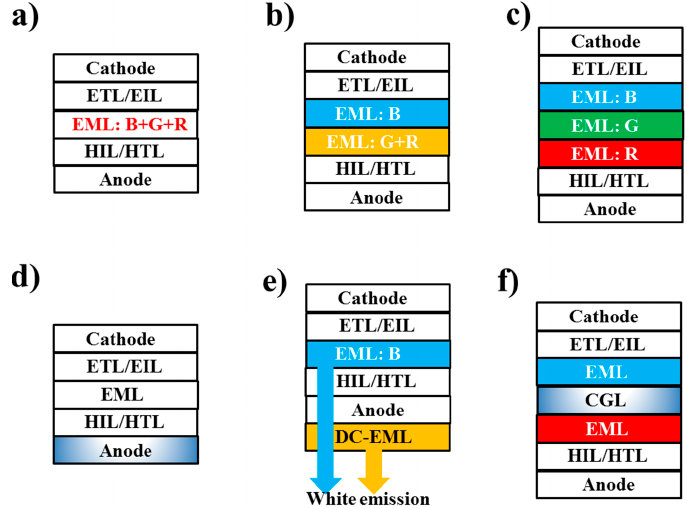
Figure 3. Schematic diagram of device architectures of WOLEDs. HIL is the hole injection layer, HTL is the hole transport layer, ETL is the electron transport layer, EIL is the electron injection layer, DC-EML is the down-conversation EML, B is blue, G is green, and R is red. ( a ) Single-EML WOLEDs; ( b ) Double-EML WOLEDs; ( c ) Triple-EML WOLEDs; ( d ) Microcavity WOLEDs; ( e ) Down-conversation WOLEDs; ( f ) Tandem WOLEDs.